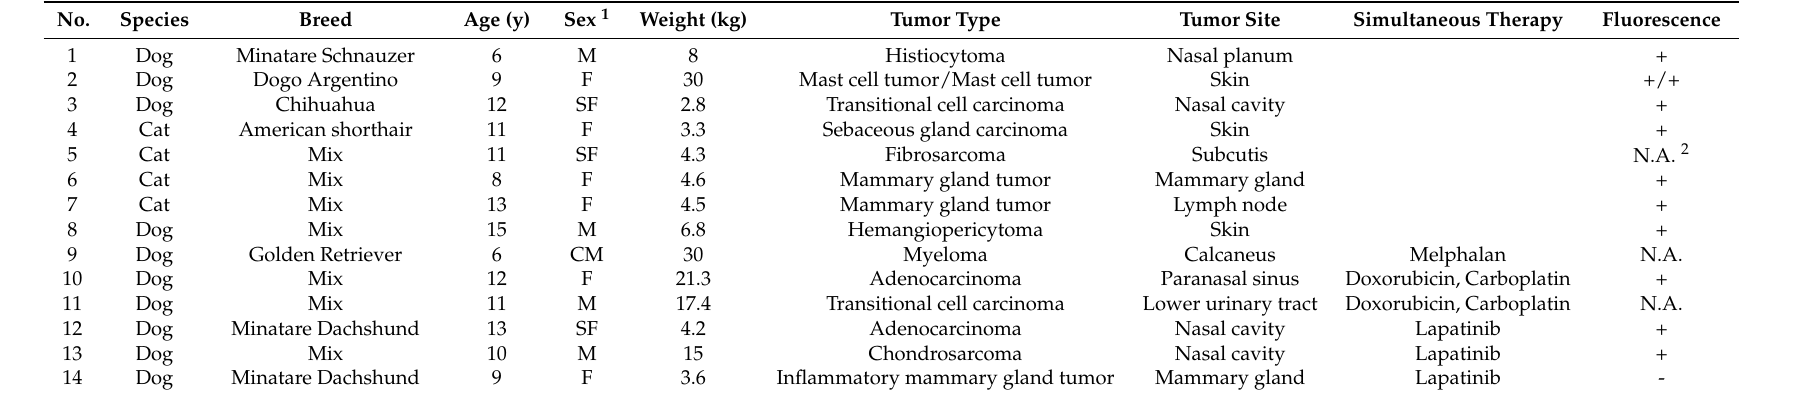
Table 2. Summary of the subjects treated with photodynamic therapy using 5-aminolevulinic acid.